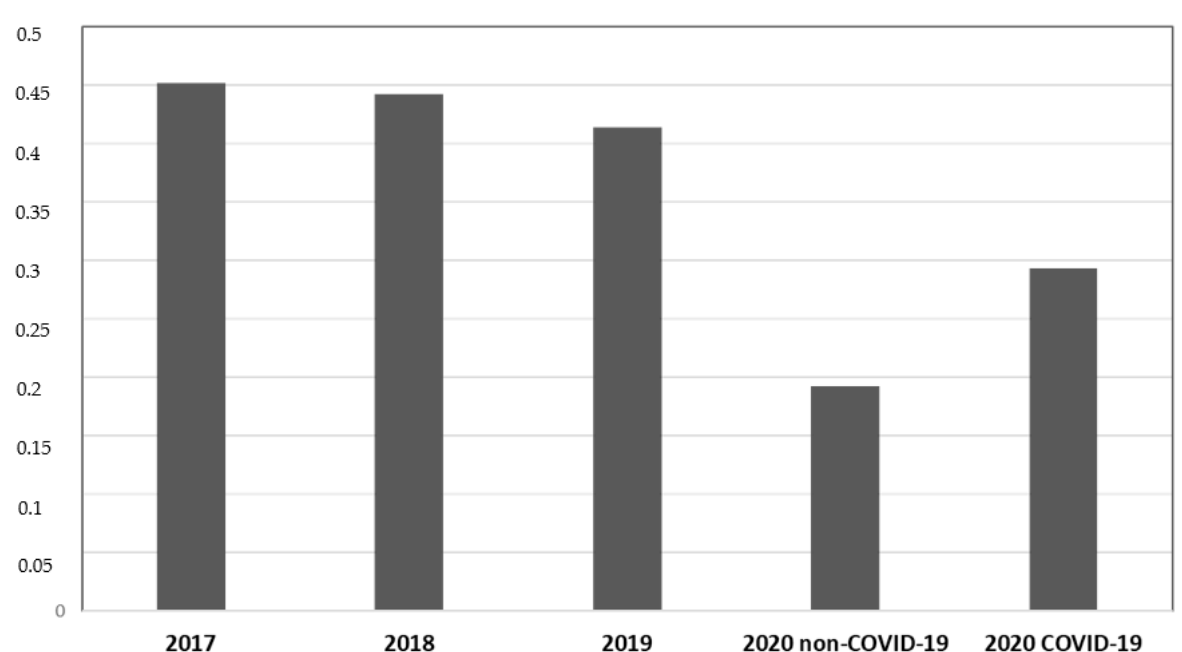
Figure 1. Data from medical departments between 1 March and 30 June. The ordinate axis represents the infection incidence of MDR bacteria. The abscissas axis represents time.